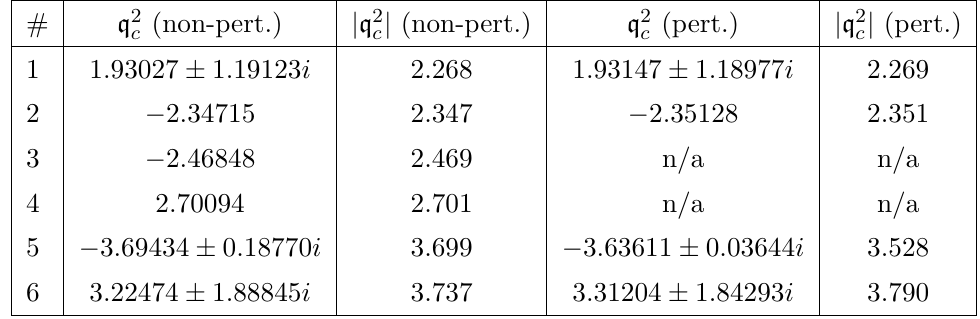
Table 1 . The six closest to the origin (in the complex q 2 -plane) critical points for γ = 1 · 10 − 5